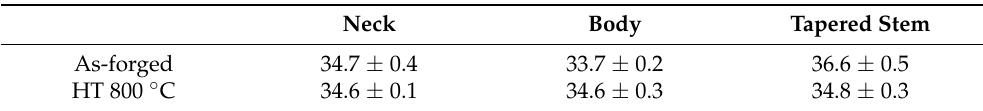
Figure 10. Digital micrograph showing the grains size and morphology of the prior β grain after annealing heat-treatment. Table 4. Average HRC hardness of the as-forged and heat-treated conditions for each region of interest of the Ti-6Al-4V DPF ELI hip